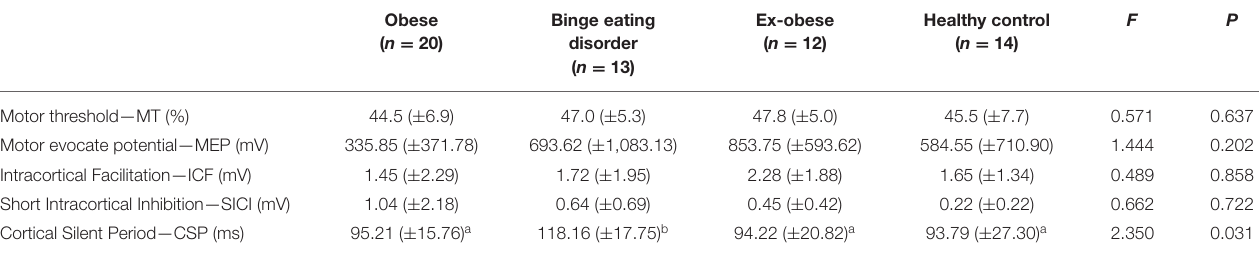
TABLE 2 | Cortical excitability measures assessed by the